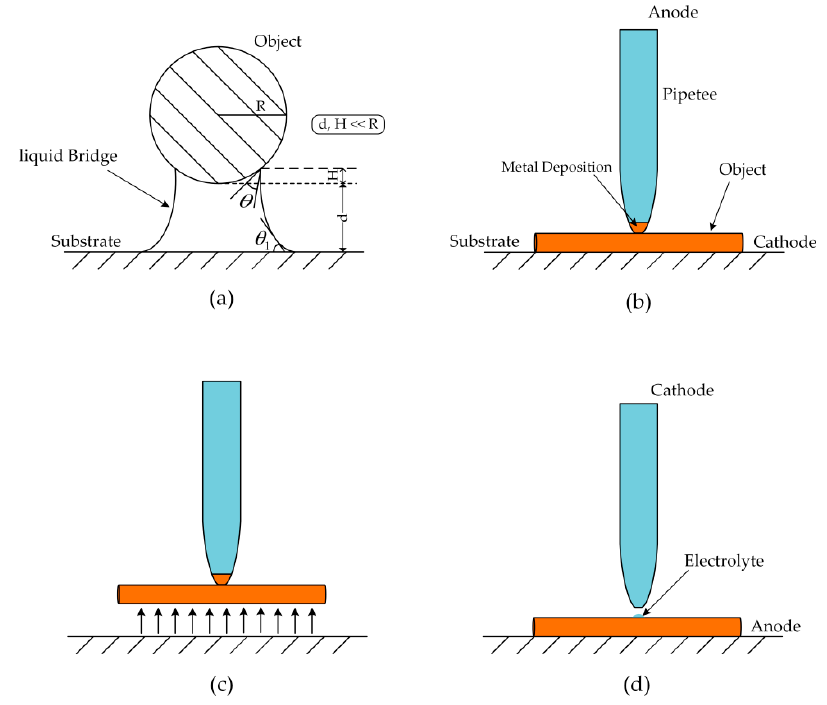
Figure 7. ( a ) The liquid bridge between the substrate and the copper microwire; ( b ) deposition; ( c ) pickup; ( d ) release.